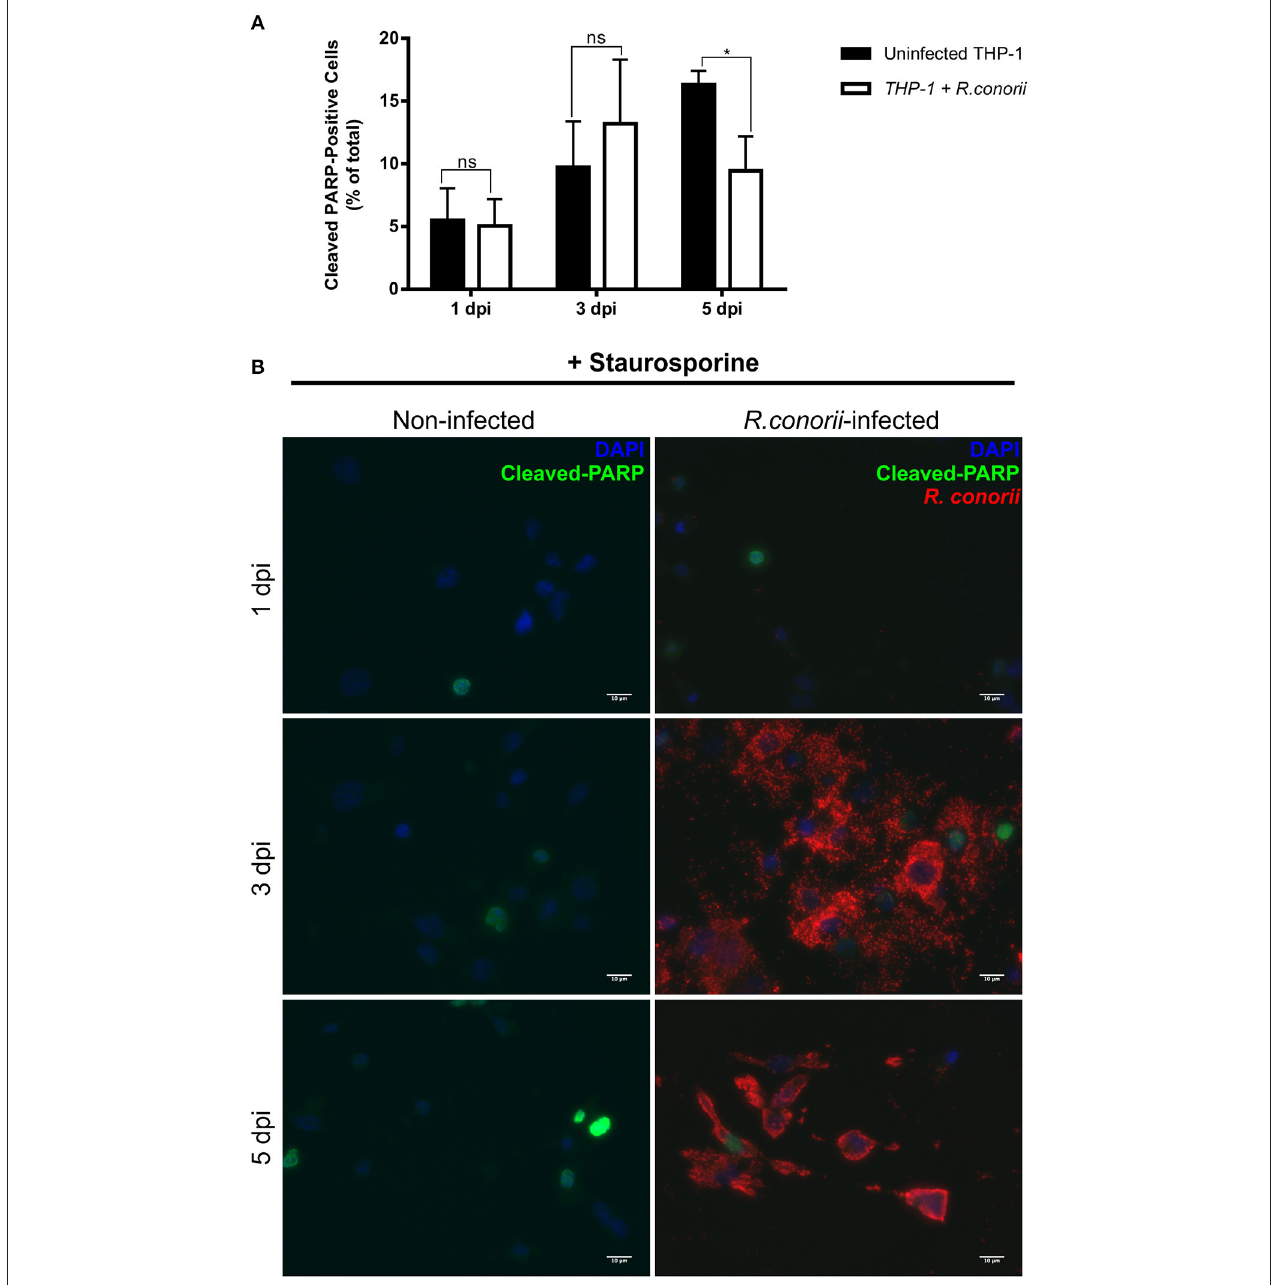
FIGURE 7 | Rickettsia conorii inhibits staurosporine-induced death of THP-1 macrophages at 5 days post-infection. (A) Uninfected and R. conorii -infected THP-1 macrophages at 1, 3, and 5 days post-infection were treated with staurosporine (750nM) for 4h. The percentage of cleaved PARP-positive cells in each experimental condition is shown as the mean ± SD and differences were considered ns (non-significant) at P > 0.05 or significant at * P < 0.05. (B) Immunofluorescence microscopy of uninfected cells and THP-1 macrophages infected with R. conorii at 1, 3, and 5 days post-infection upon challenge with staurosporine (750nM) for 4h. Cells were stained with DAPI (blue) to identify host nuclei, mouse anti- Rickettsia antibody (5C7.31) followed by anti-mouse Alexa Fluor 594 (red) to identify R. conorii and rabbit anti-cleaved poly(ADP-ribose) polymerase (PARP) followed by anti-rabbit Alexa Fluor 488 (green) to identify cleaved PARP-positive cells. Scale bar = 10 µ m.